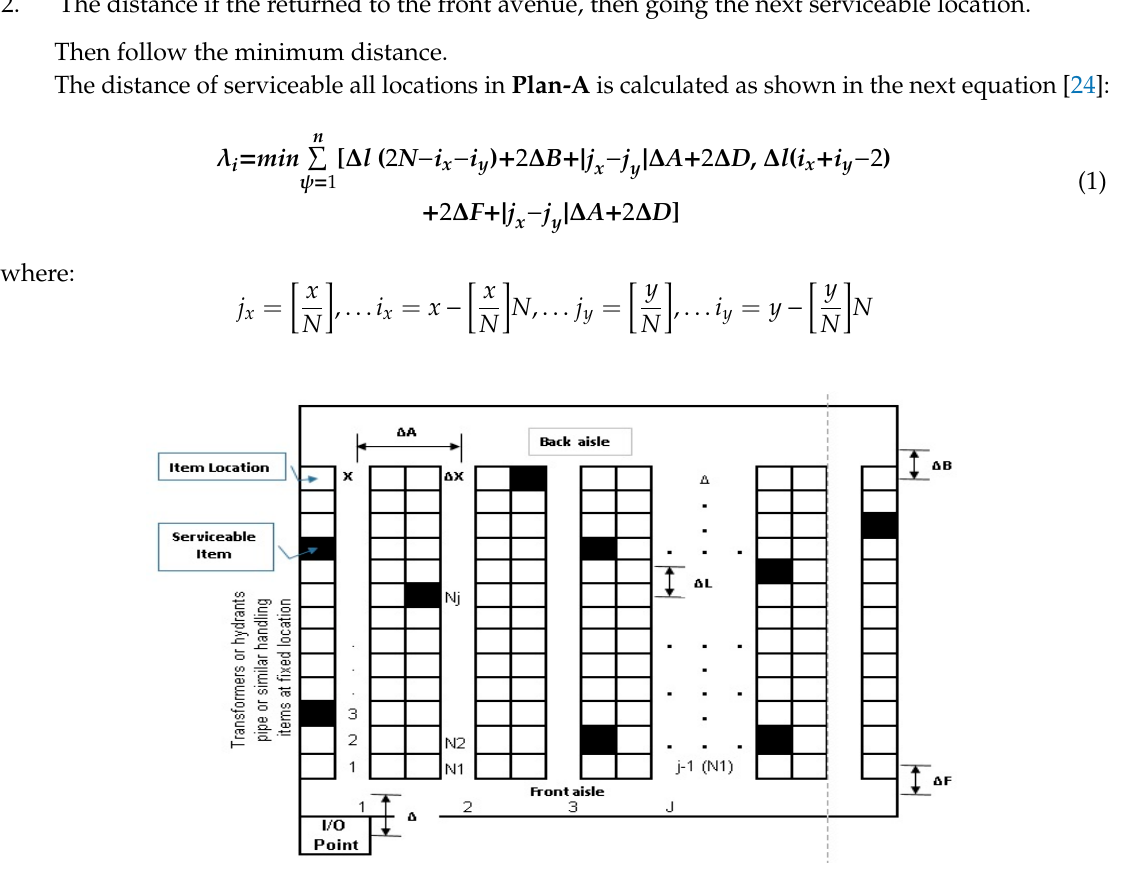
Figure 4. Illustrative examination layout. Table 1. Symbols used in the proposed plan model illustrated in Figure 3.